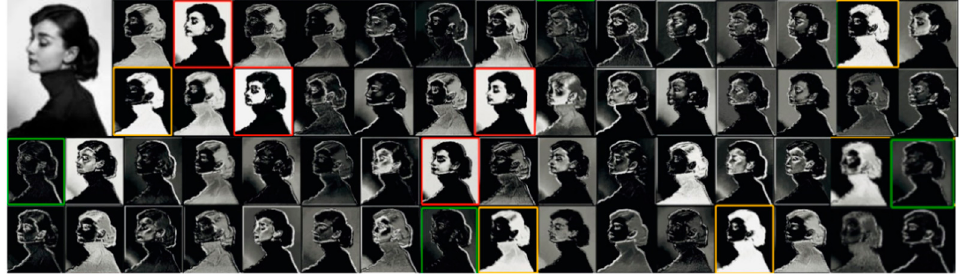
Figure 2. Visualize the input images of the dynamic MobileNet V1 and the feature maps of the first layer. Select similar feature maps from them and mark them with red, yellow, and green boxes. The feature maps marked with the same color are basically the same, so select representative feature maps can be used for input, and the remaining redundant information will increase the number of network parameters.